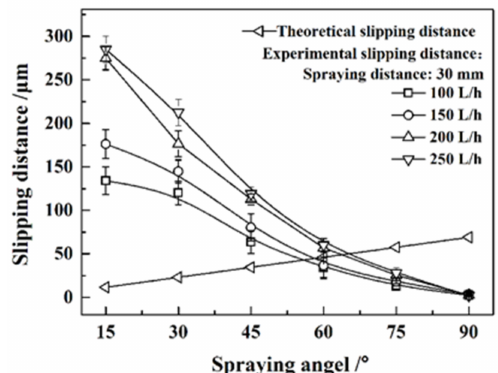
Figure 9. Slipping distance of solid core of spray particles at different impact angles through experimental conversion and theoretical